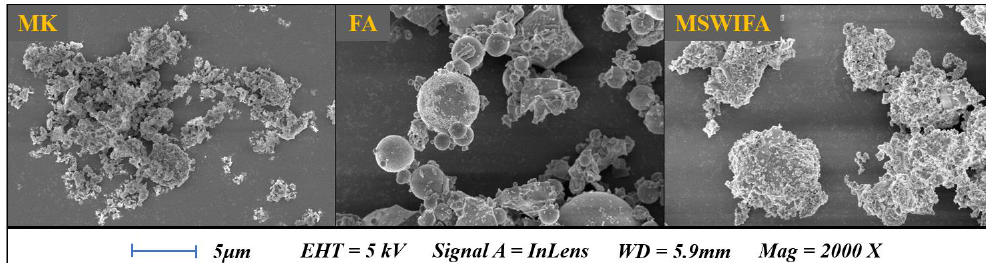
Figure 1. The SEM images of MK, FA, and MSWIFA.